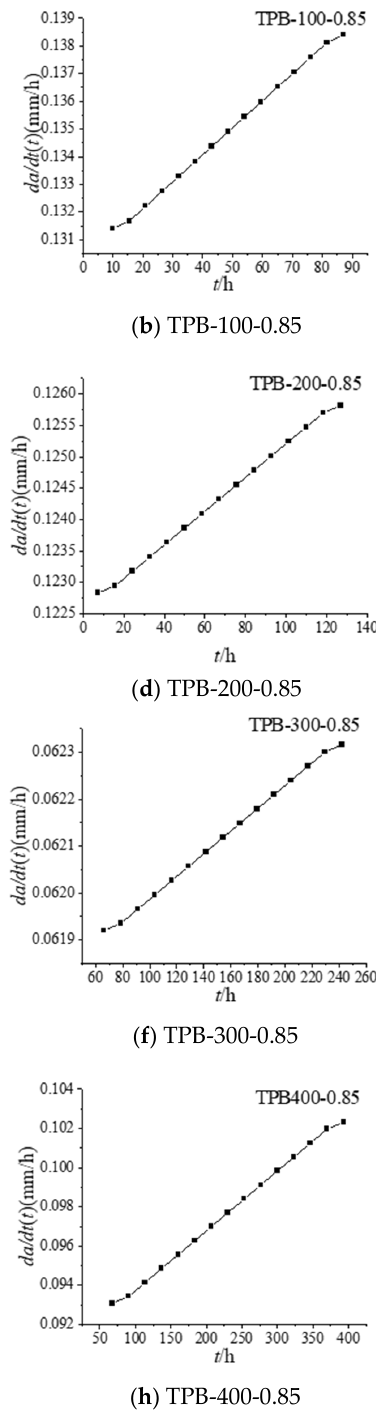
Figure 2. Time ‐ dependent fracture curves da/dt (t) ‐ t. Figure 2. Time-dependent fracture curves da/dt (t)-t